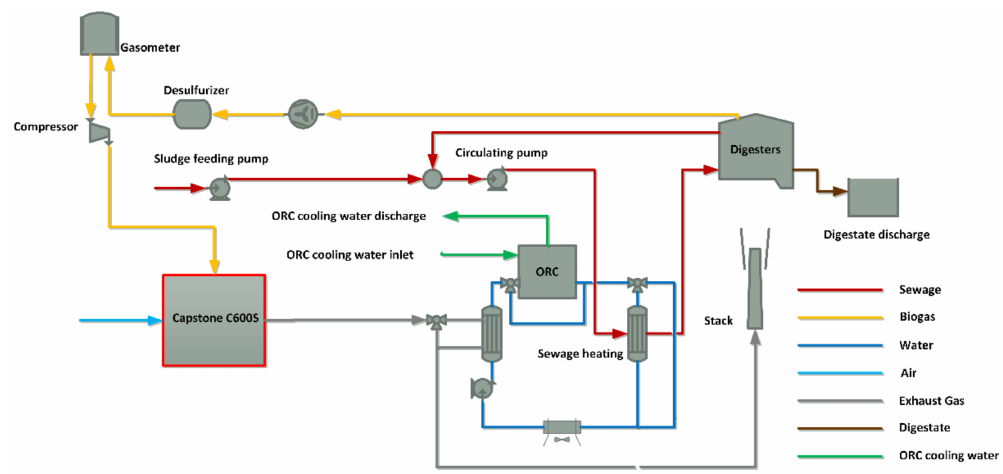
Figure 2. Histograms of biogas facility operating conditions (average hour values). ( a ) Heat flow rate required by the . Q dig in kW th . ( b ) mGT exhaust mass flow rate digester from [11].